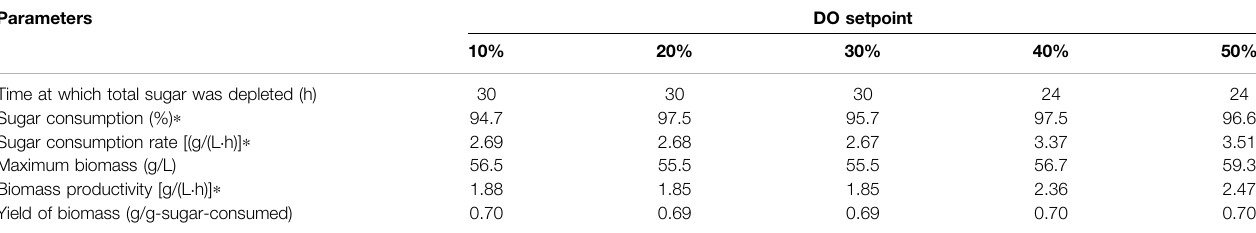
TABLE 4 | Kinetic parameters of Paracoccus sp. KKU01 cultivation on the optimum medium at DO setpoints ranging from 10% to 50%. Parameters DO setpoint